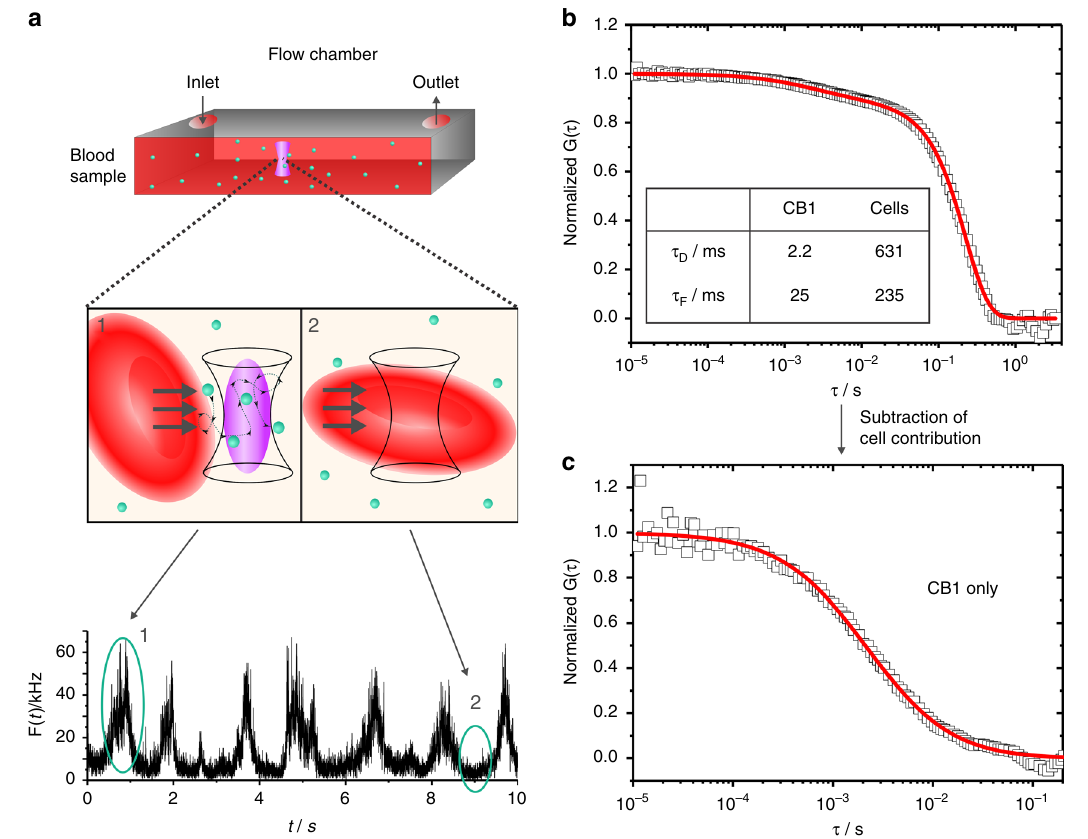
Fig. 2 Overview of the NIR-FCS experiments and data analysis in fl owing blood. a Monitoring NIR fl uorescent species in fl owing blood. Blood containing CB1 (8 nM) was pumped through a fl ow channel at a de fi ned velocity of 50 µ L h − 1 . The FCS observation volume was consequently either free (schematics 1) or occupied (schematics 2) by a blood cell. Correspondingly, the fl uorescence intensity time trace revealed high (1) and low (2) intensity time segments. b The experimental autocorrelation curve (squares) was fi tted (line) with analytical model, Eq. (3), combining standard and inverse FCS thus taking into account contributions of fl uorescent species and blood cells, respectively. c The information extracted from the fi t in panel ( c ) was used to subtract the cells ’ contribution and obtain an autocorrelation curve (squares) resembling that of a standard FCS experiment (Eq. ( 6)). A fi t with Eq. (1) (line) yields diffusion properties of the fl uorescent